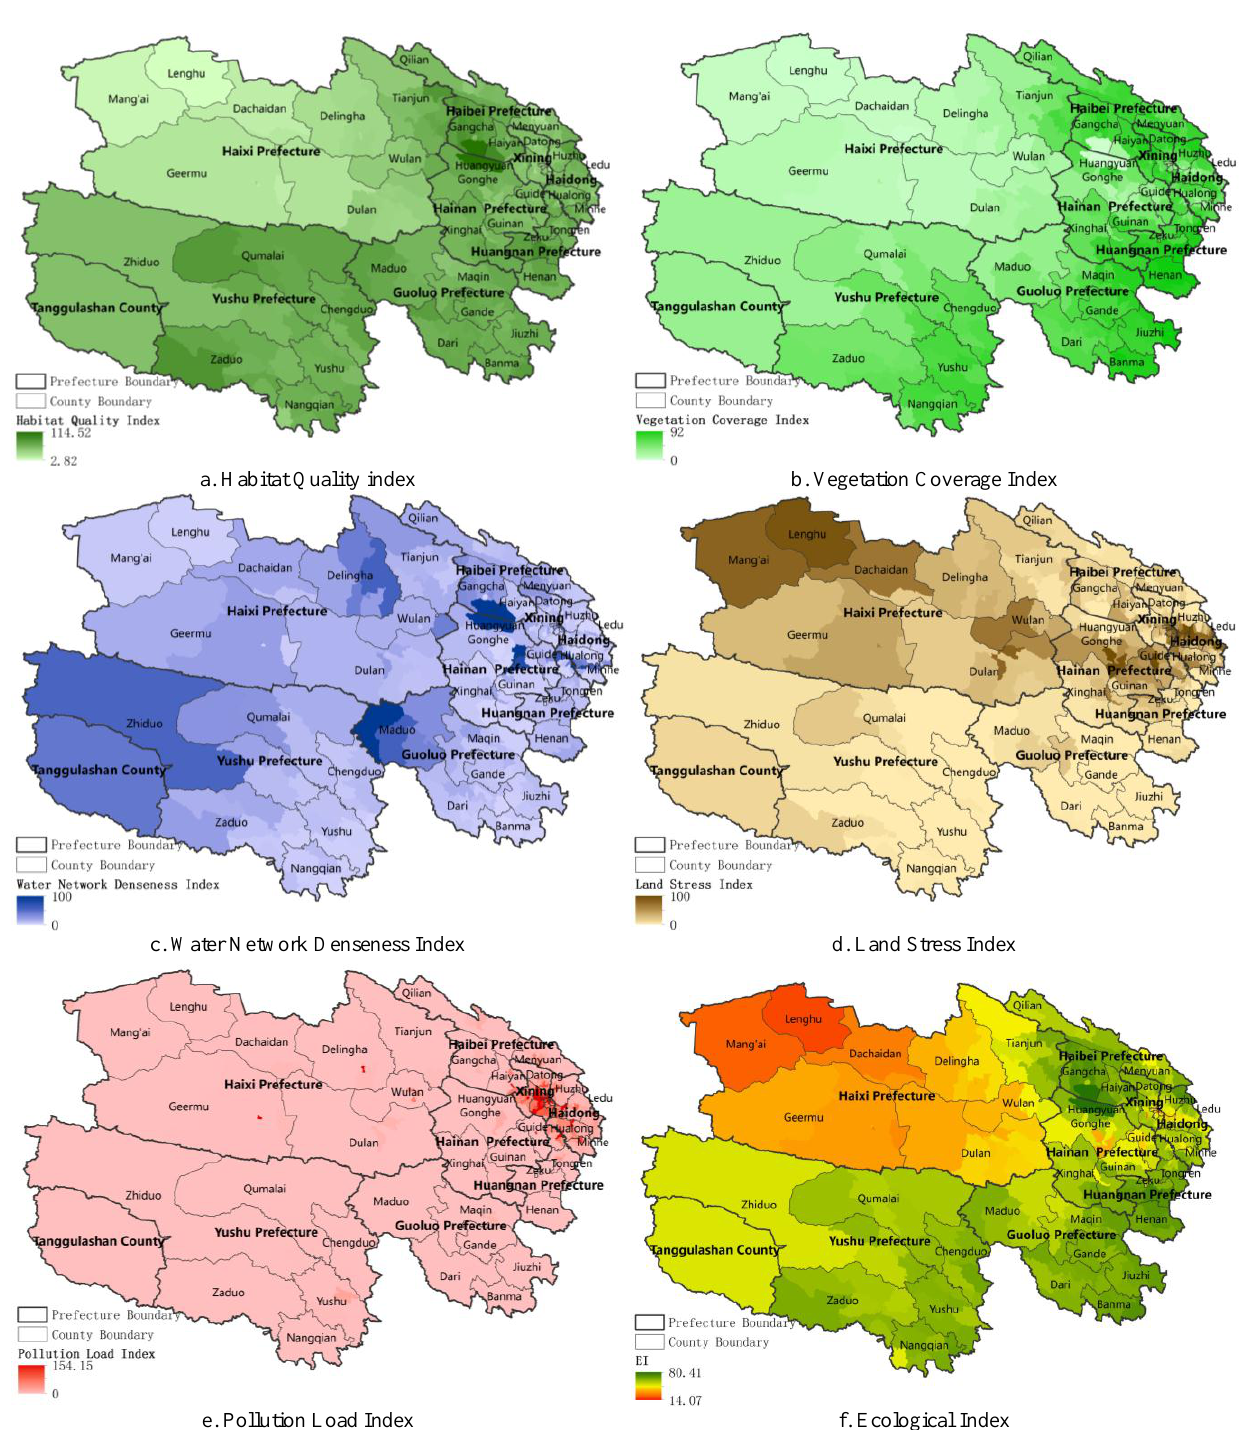
Figure 2. Eco-environment indices of Qinghai in